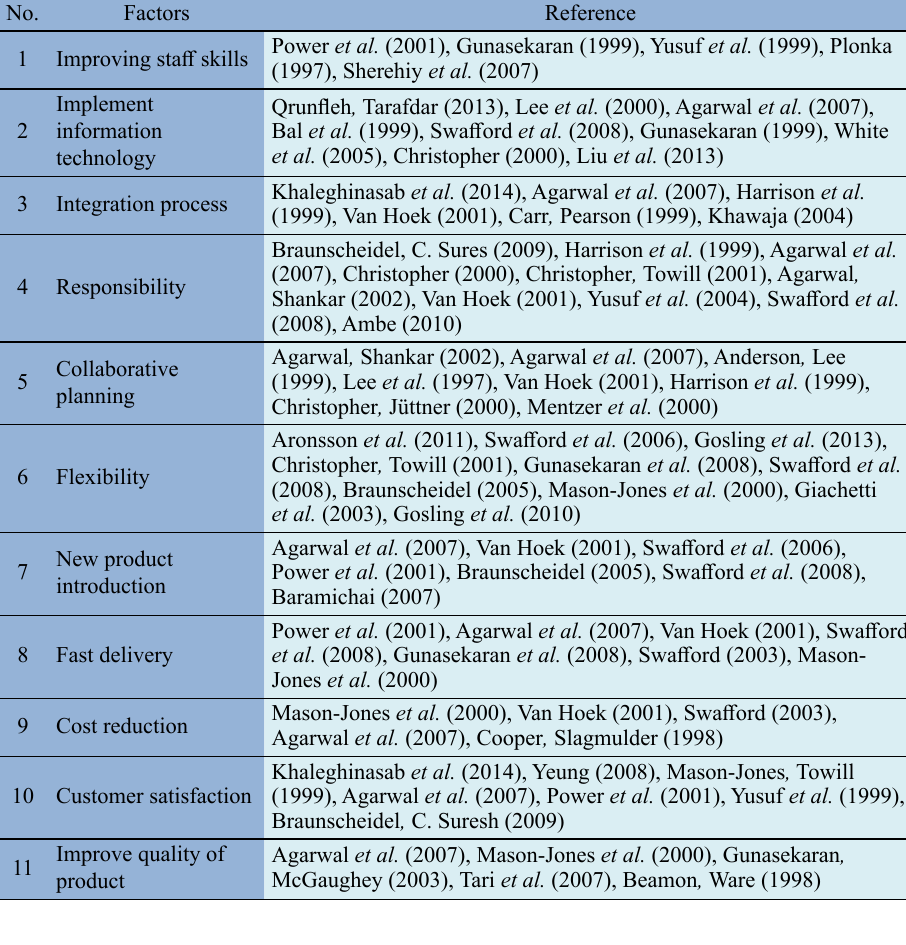
Table 1. Agility factors identified by authors through literature review ReferenceFactorsNo.